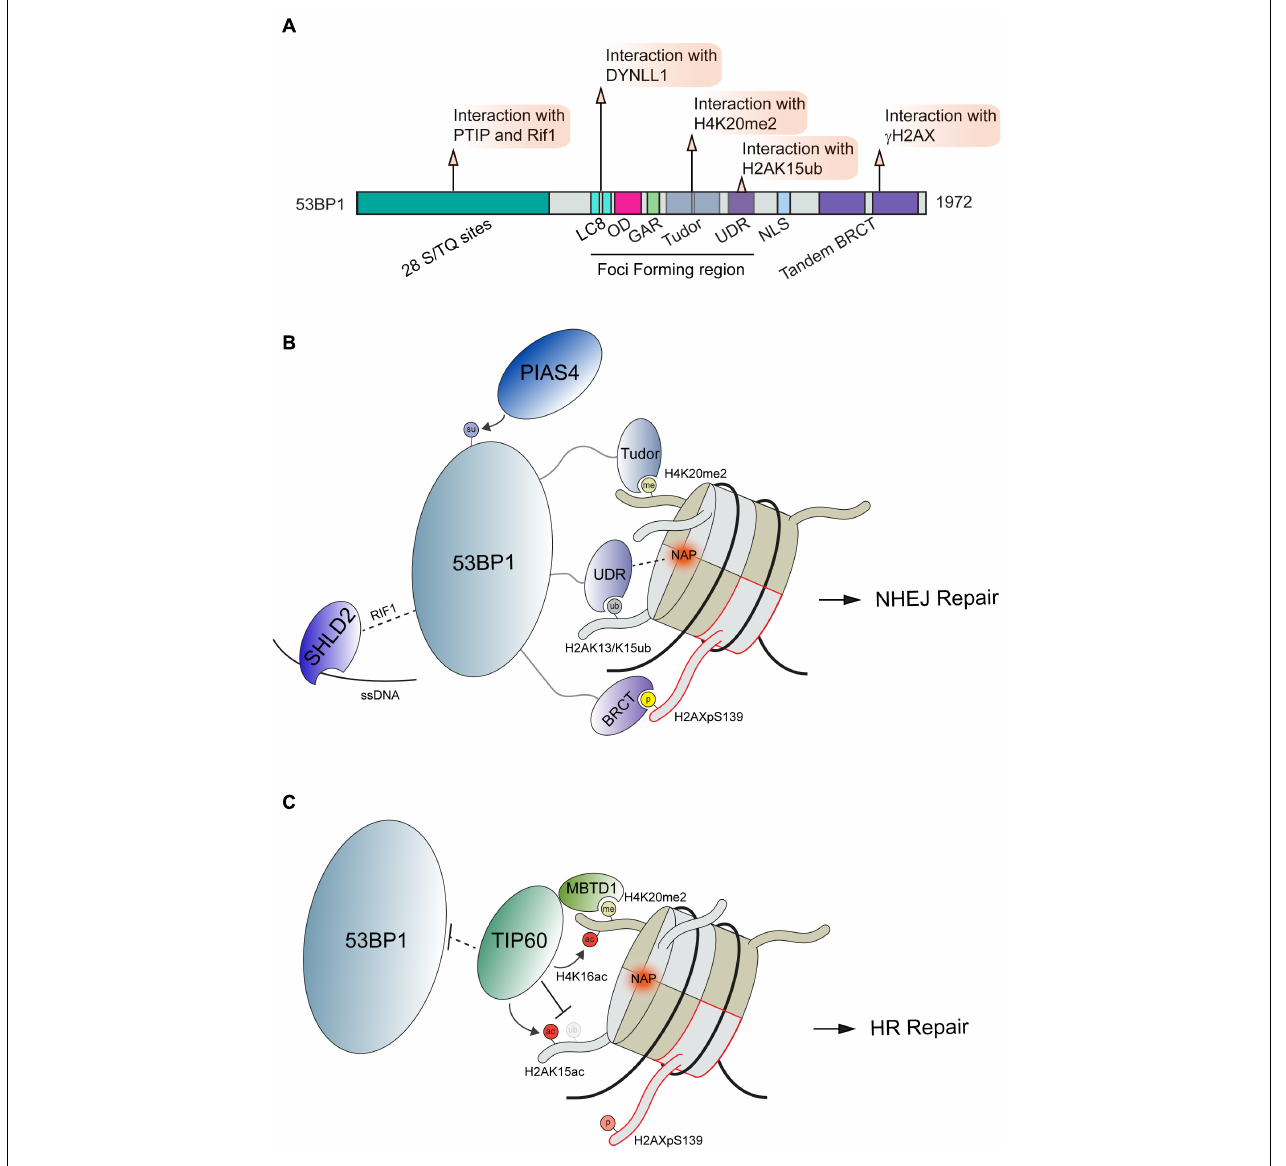
FIGURE 2 | Interactions and regulation of 53BP1 during DSB repair. (A) Domain map of 53BP1 and DDR related interactions. (B) Schematic interactions between 53BP1 and chromatin proximal to DNA damage sites. 53BP1 engages with chromatin through recognition of H4K20me2 by its tandem tudor domains, interacting with the NAP and H2AK13/K15ub via its UDR domain and binding to H2AXpS139 via its BRCT domain. These interactions along with the others shown position 53BP1 on nucleosomes. (C) Negative regulation of 53BP1 by the histone acetyltransferase TIP60. To antagonize 53BP1 function TIP60 prevents access to H4K20me through its association with MBTD1 while also acetylating H4K16 and H2AK15. PTIP, Pax Transactivation domain-Interacting Protein; RIF1, Replication Timing Regulatory Factor 1; DYNLL1, Dynein Light Chain LC8-Type 1; OD, Oligomerization Domain; GAR, Glycine/arginine Rich Domain; UDR, Ubiquitin-Dependent Recruitment Domain; NLS, Nuclear Localization Sequence; BRCT, BRCA1 C-terminus domain; PIAS4, Protein Inhibitor Of Activated STAT 4; SHLD2, SHieLDin complex subunit 2; TIP60, 60 kDa Tat-Interactive Protein; MBTD1, MBT Domain Containing 1; NAP, Nucleosome Acidic